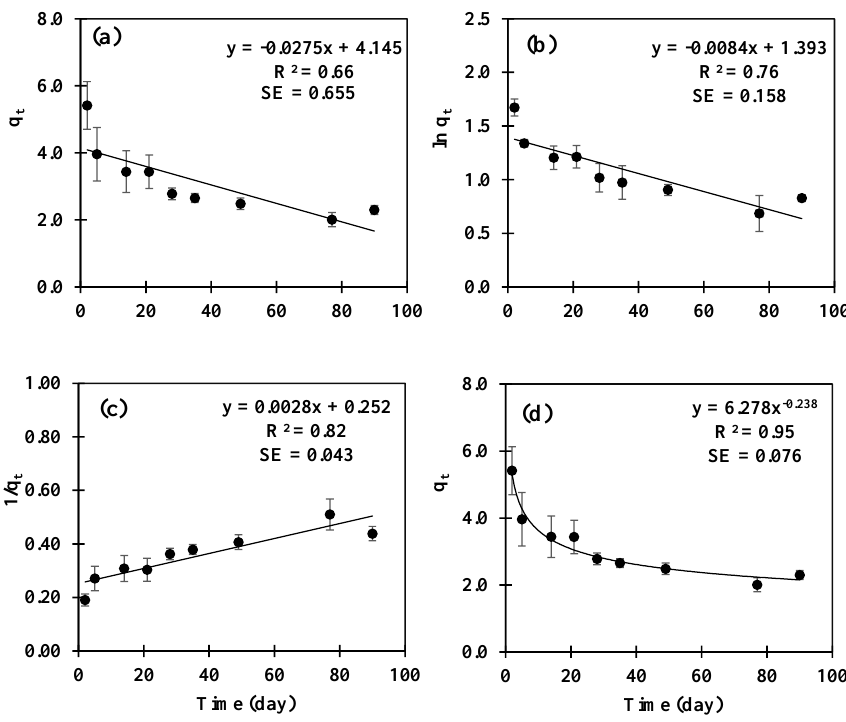
Figure 1. Diethylenetriaminepentaacetic acid (DTPA)-extractable Zn over the long term (90 days) in the non-chelated system fitted to (a) zero-order, (b) first-order, (c) second-order, and (d) power-function models ( q t is the amount remaining at time t (mgkg − 1 ); error bars are for standard errors computed from six data